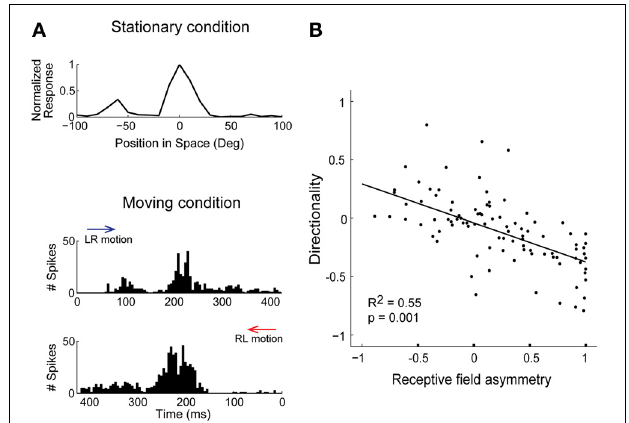
FIGURE 3 | Response history predicts direction selectivity in ICx. (A) Spatial tuning in the horizontal plane measured with sound bursts presented in no particular order (stationary condition). The response is asymmetric around the center, displaying a larger response to the left. Bottom, during moving sounds, the response varied with direction. Motion in the left-to-right direction (LR, blue arrow) induced a less robust response at the center than the right-to-left direction (RL, red arrow). (B) Asymmetry of receptive fields was correlated with the preferred direction and strength of direction selectivity. Directionality and asymmetry are represented using normalized indices. Modified from Wang and Pena (2013).